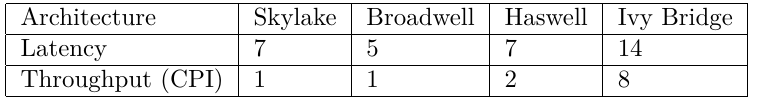
Table 4: Performance of the PCLMULQDQ instruction in function of the architecture, as presented in the Intel Intrinsics